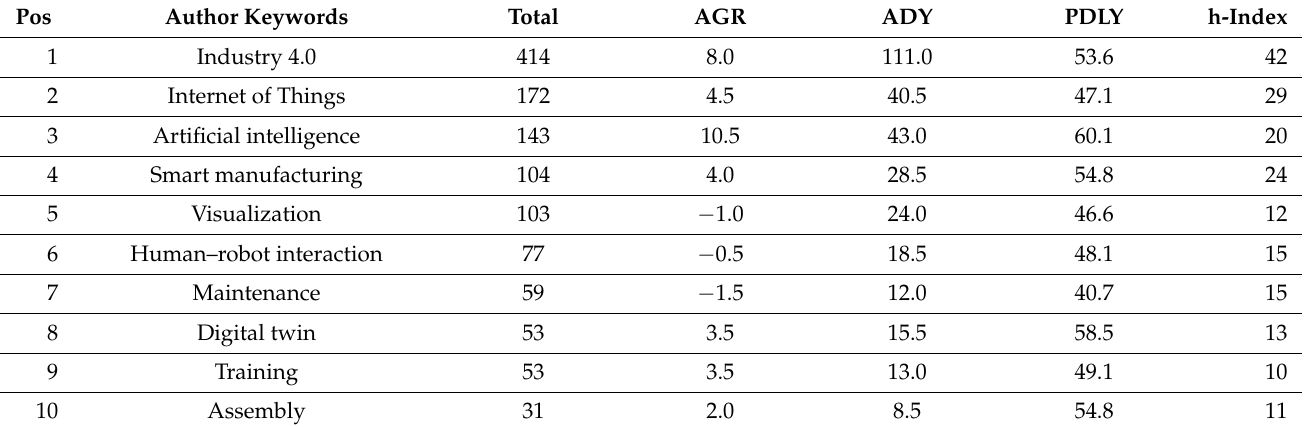
Table 1. Trend indices of selected topics.